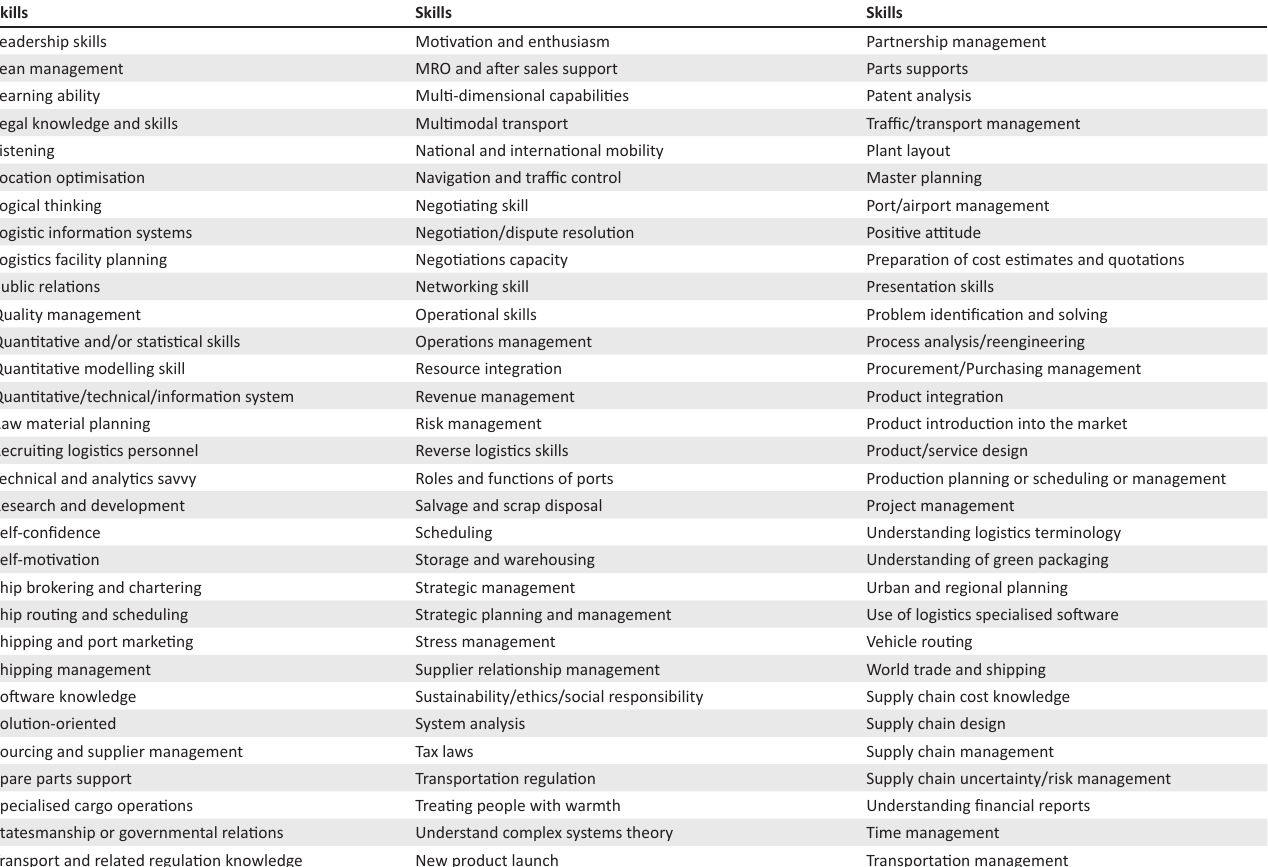
FIG URE 1-A1 (Continues...): Supply chain management